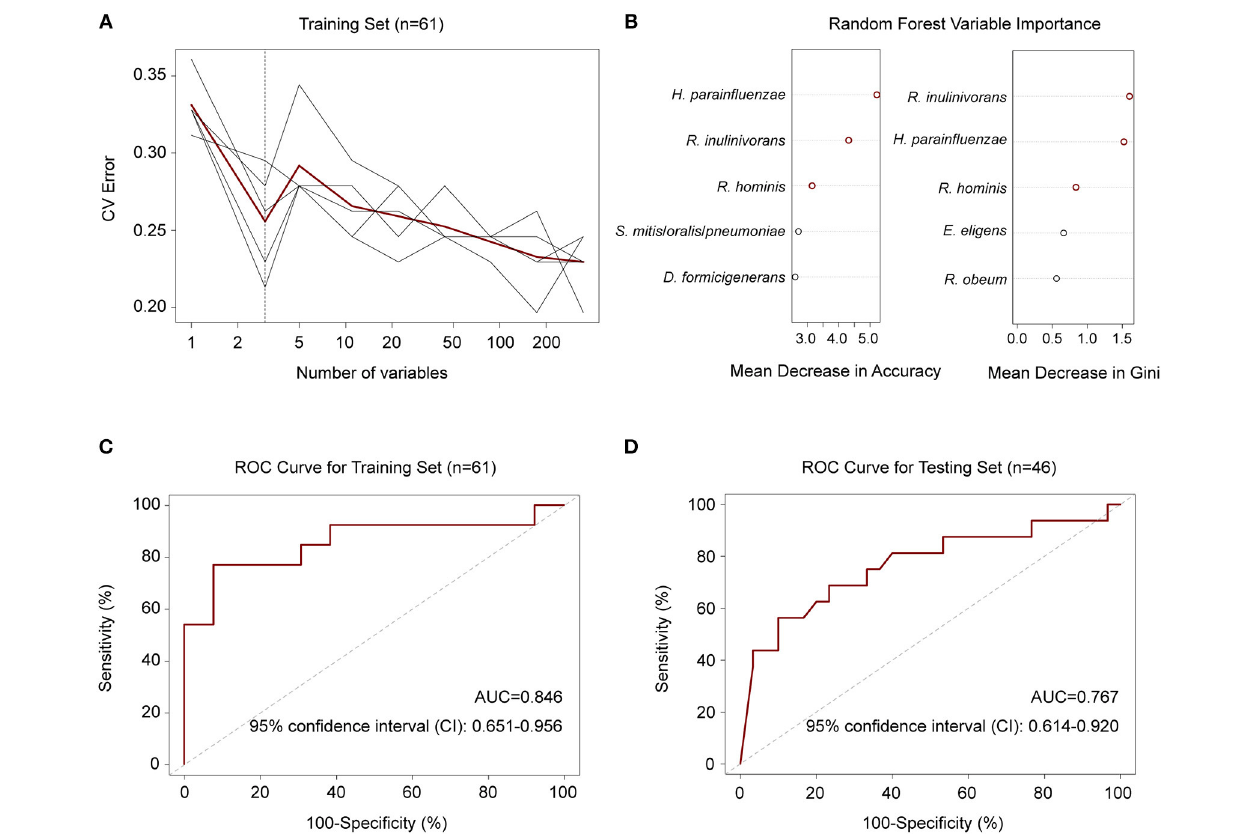
FIGURE 3 | Random forest model to discriminate TB patients from healthy controls. (A) Five repeats of 10-fold cross-validation error. Relative abundances of 348 species in controls and patients ( n = 31 and 30) were used to train the model. Each gray line indicates a repeat, and the red line indicated the average. The dashed line indicates the number of species in the optimal set, which was determined to be 3 species. (B) Random forest Mean Decrease in Accuracy and Gini. Red circles indicate the 3 species in the optimal set according to cross-validation in (A) . (C) ROC for the training set. AUC = 0.846 and the 95% CI is 0.651–0.956 (controls, n = 31; patients, n = 30). (D) ROC for the testing set. AUC = 0.767 and the 95% CI is 0.614–0.920 (controls, n = 30; patients, n = 16).